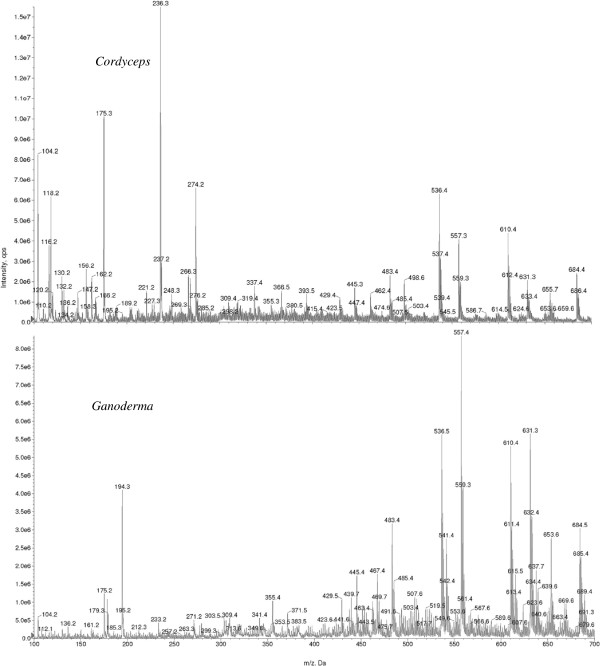
FI/MS fingerprints ofCordyceps(top) andGanoderma(bottom) at concentration level of 1 mg L-1obtained by performing EMS scan (positive mode) fromm/z100 to 700 using the LIT.